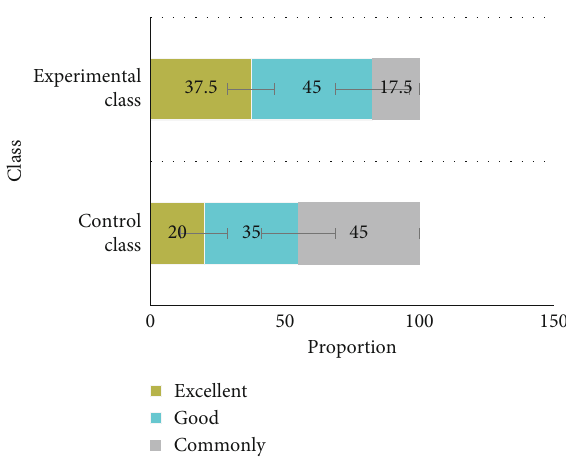
Figure 4: The proportion of grades in two classes.